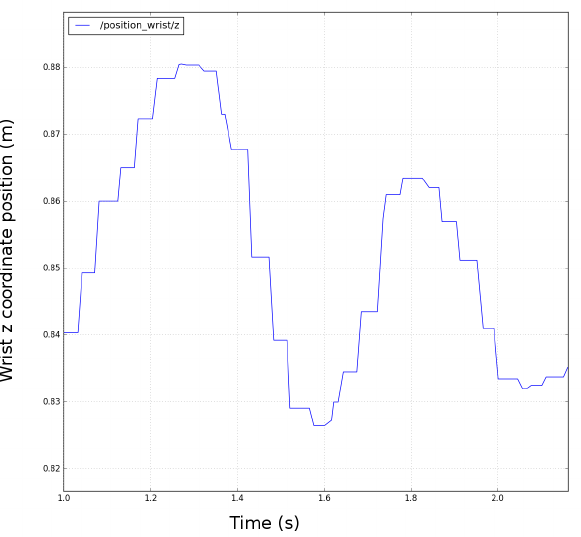
Figure 8: Predefined arm motion to perform the handshake.